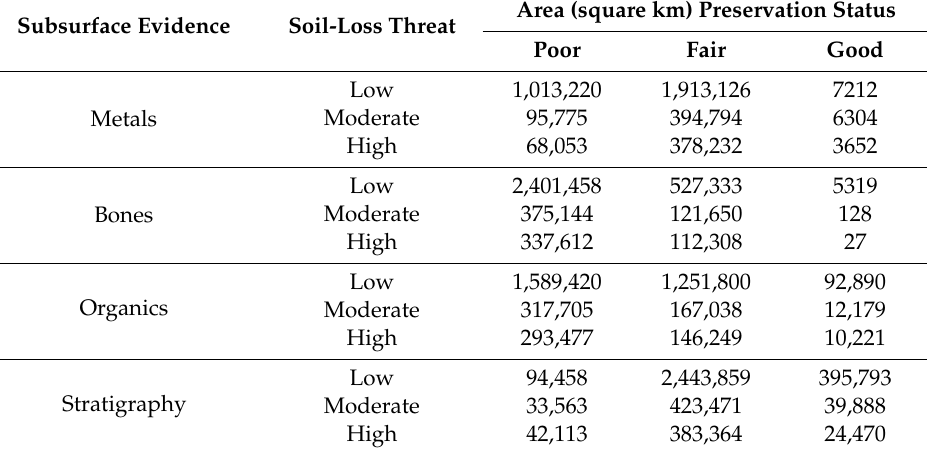
Table 1. Absolute areas of the subsurface materials studied here (metals, bones, organics, and stratigraphy) per soil threat (low, moderate, and high) and preservation status (poor, fair, and good).